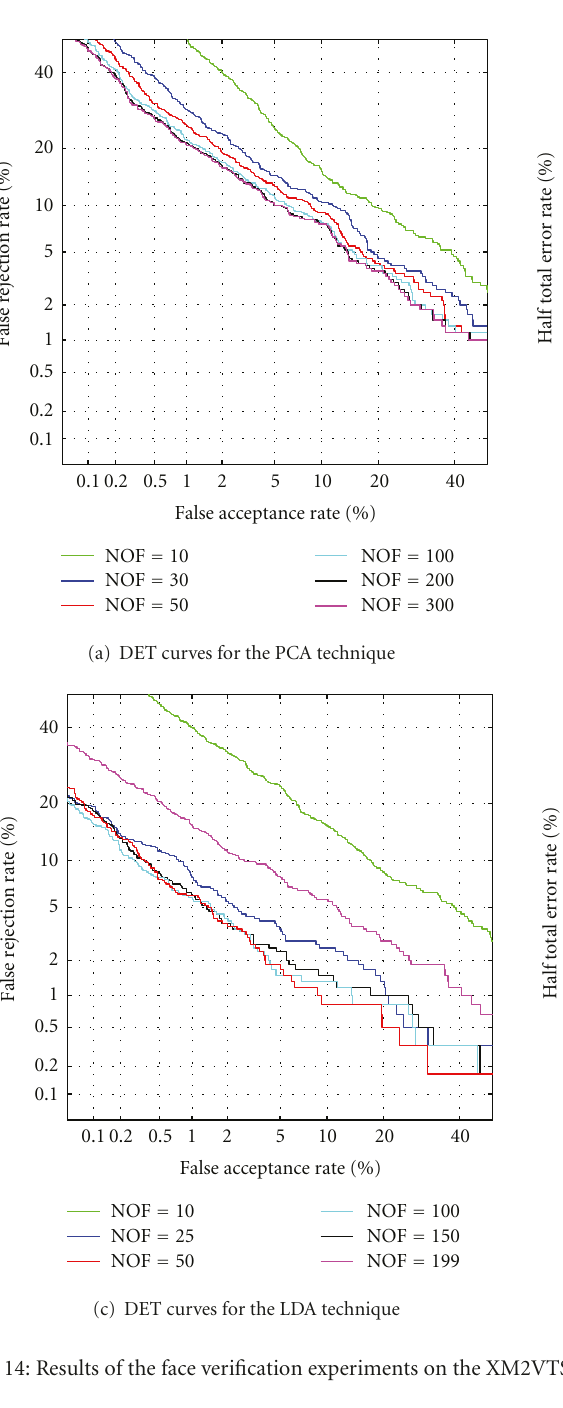
performance. Note that again only the XM2VTS and EYB databases are employed in the